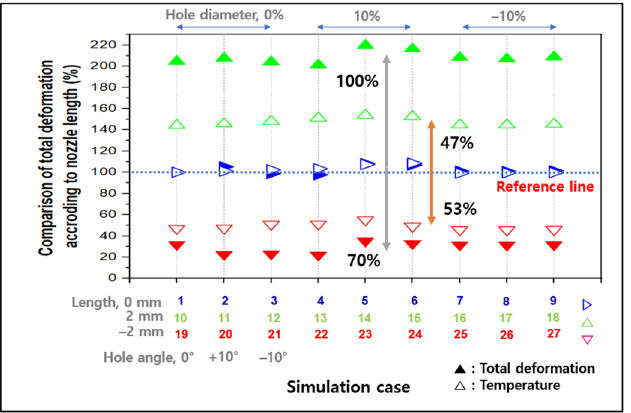
Figure 10. Comparison of total deformation based on the original nozzle according to nozzle length.